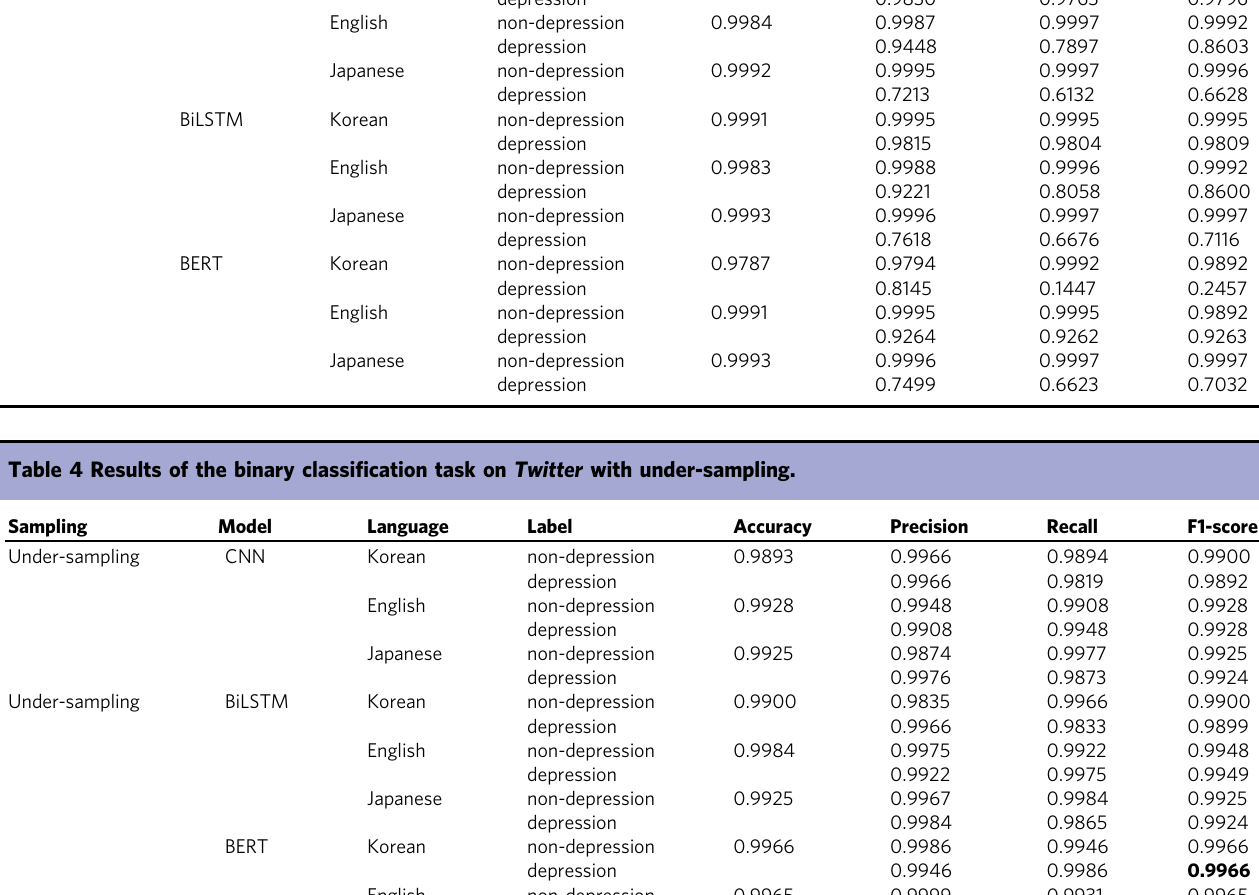
Table 3 Results of the binary classi fi cation task on Twitter with normal sampling.